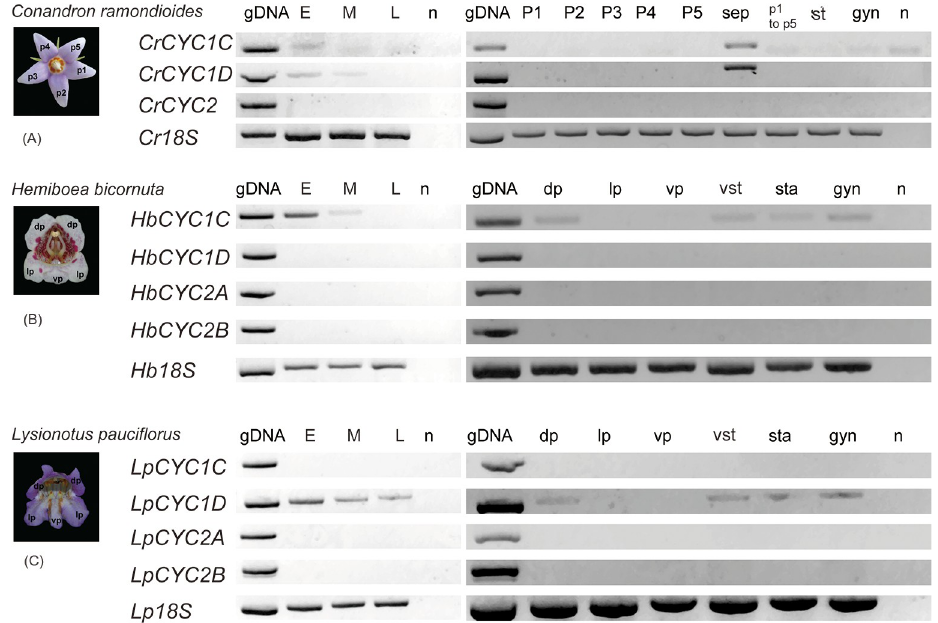
Fig 4. Expression pattern of GCYC in floral parts of Conandron ramondioides , Hemiboea bicornuta , and Lysionotus pauciflorus . (A) Conandron ramondioides . (B) Hemiboea bicornuta . (C) Lysionotus pauciflorus . E: Early Stage flower bud, M: Middle Stage flower bud, L: flower bud at anthesis; n denotes no-template control; dp: dorsal petals, lp: lateral petals vp: ventral petal; p1 to p5: pooled C . ramondioides petals; st: pooled stamens ( C . ramondioides ); vst: ventral stamens, sta: staminodes ( H . bicornuta , L . pauciflorus ); gyn: gynoecium; sep: pooled sepals ( C . ramondioides ). A very faint band appears sometimes in no-template controls in C . ramondioides and represent primer dimer artefacts (see S5 Fig).